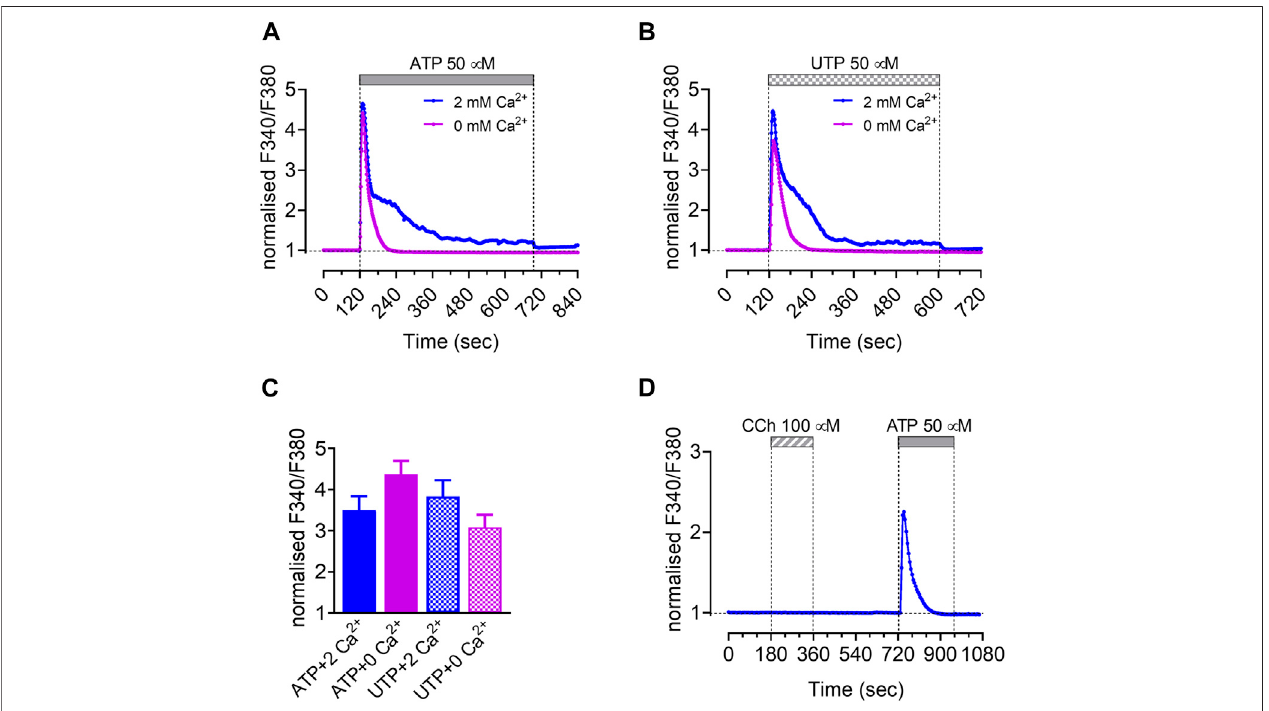
FIGURE 6 | Intracellular Ca 2+ responses of isolated HAT-7 spheroids to different agonists. Changes in intracellular Ca 2+ in response to 50 μ M ATP (n (cid:2) 5) (A) and 50 μ MUTP(n (cid:2) 3) (B) inthepresenceandabsenceofextracellularcalcium. (C) Peakvaluespresentedasmeans ± SEM(nosigni fi cantdifference). (D) Effectofcarbachol (100 μ M, n (cid:2) 3) on intracellular Ca 2+ concentration. An ATP stimulus was applied subsequently to test the responsiveness of the spheroids. Panels show representative traces. Data are presented as changes in fura-2 fl uorescence ratio normalized to